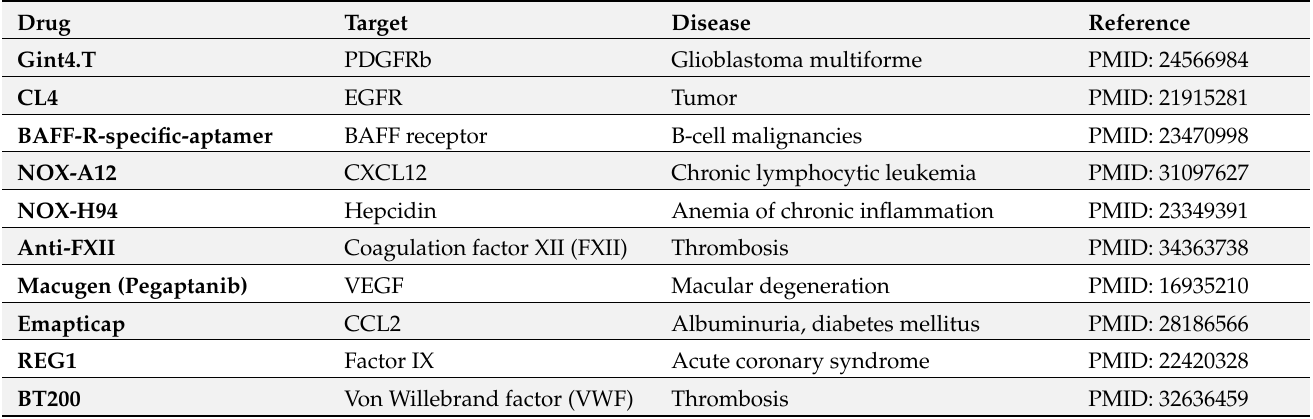
Table 3. List of aptamers used in clinics or under clinical trials for several human